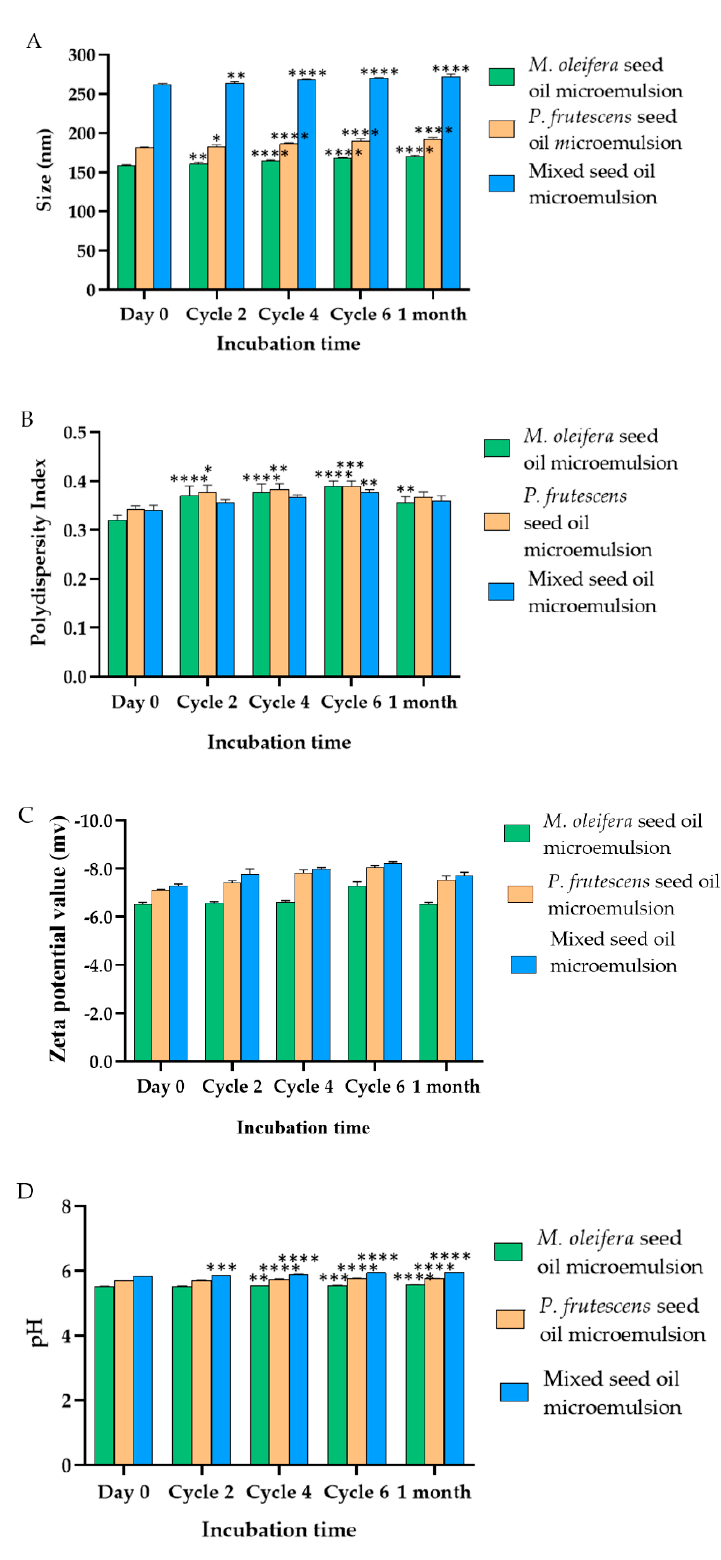
Figure 2. ( A ) Particle size, ( B ) polydispersity index, and ( C ) zeta potential values. ( D ) pH of freshly prepared microemulsion of P. frutescens , M. oleifera , and mixed seed oil microemulsion and microemulsions after 2, 4, and 6 cycles of heating–cooling stability test and 1 month storage at 30 °C. Data represent mean ± SD (n = 3), * indicates p < 0.05, ** indicates p < 0.01, *** indicates p < 0.001, and **** indicates p < 0.0001, compared with Day 0.